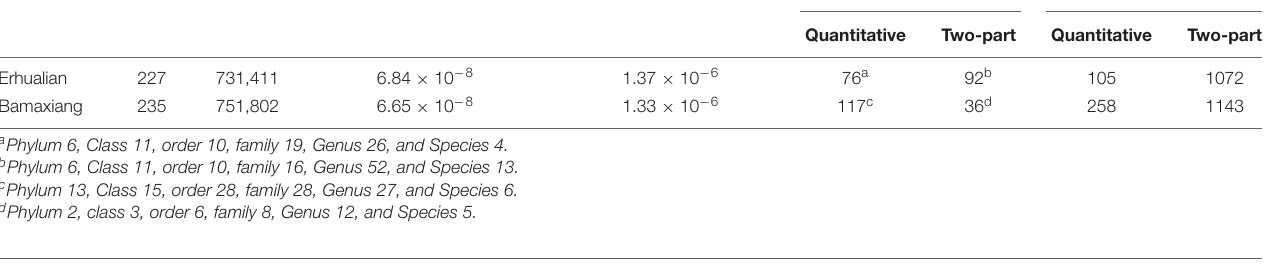
TABLE 1 | The numbers of experimental animals, SNPs, OTUs and bacterial taxa, and the significance threshold used for GWAS. Population Animal SNP Genome-wide significance Suggestive significance Taxon OTU Quantitative Two-part Quantitative Two-part